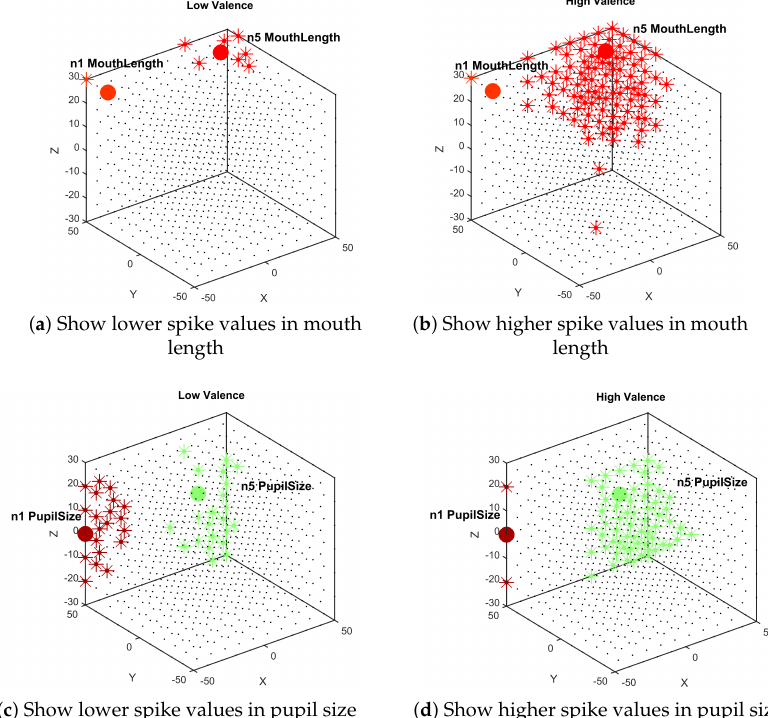
Figure 11. Neuron activity pattern example when NeuCube is trained using each Separate data (low and high